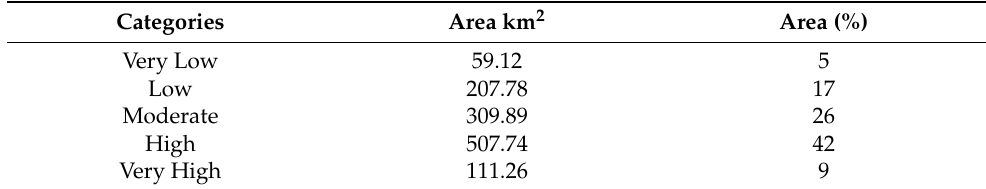
Table 6. Groundwater potential